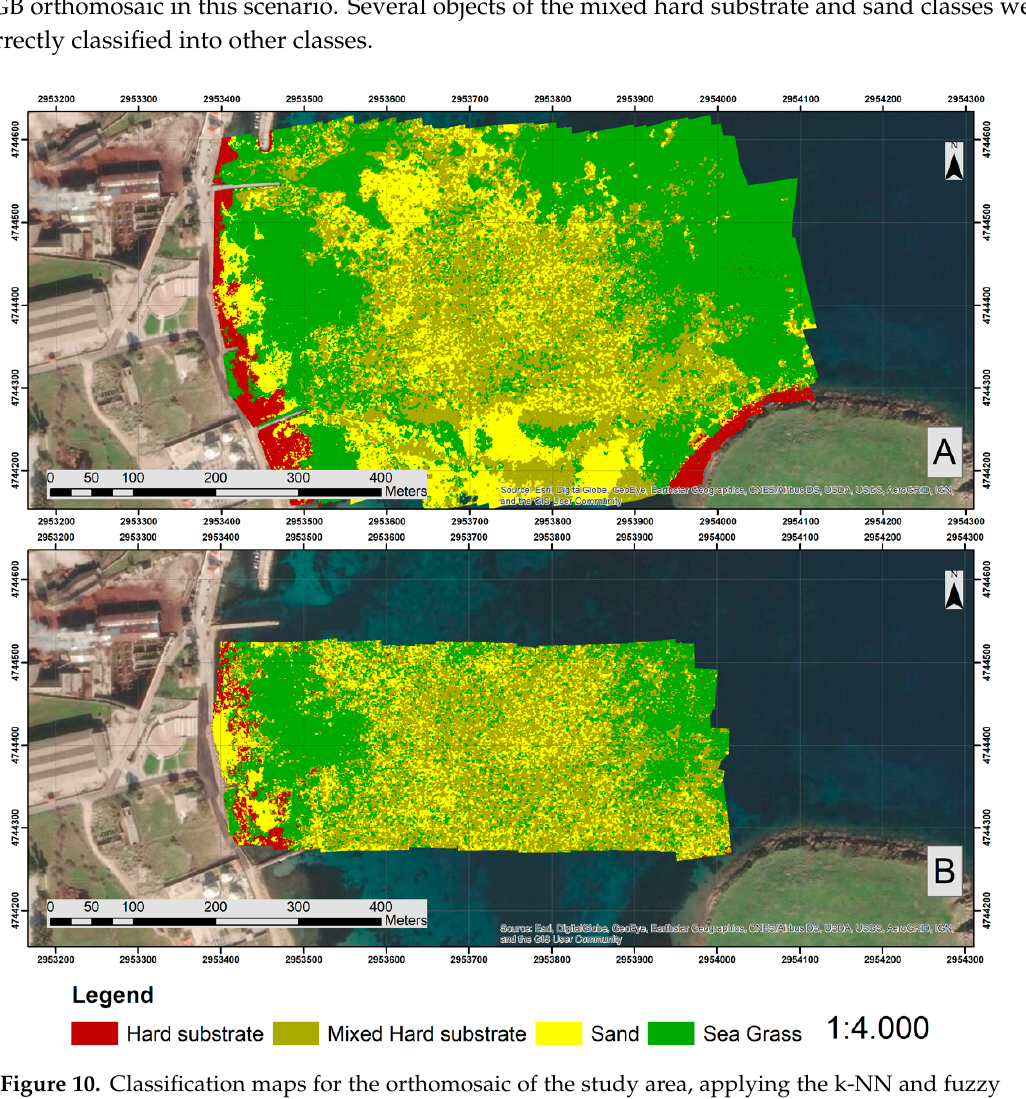
Figure 10. Classification maps for the orthomosaic of the study area, applying the k-NN and fuzzy rules: ( A ) the tc-RGB orthomosaic map and ( B ) multispectral orthomosaic map.